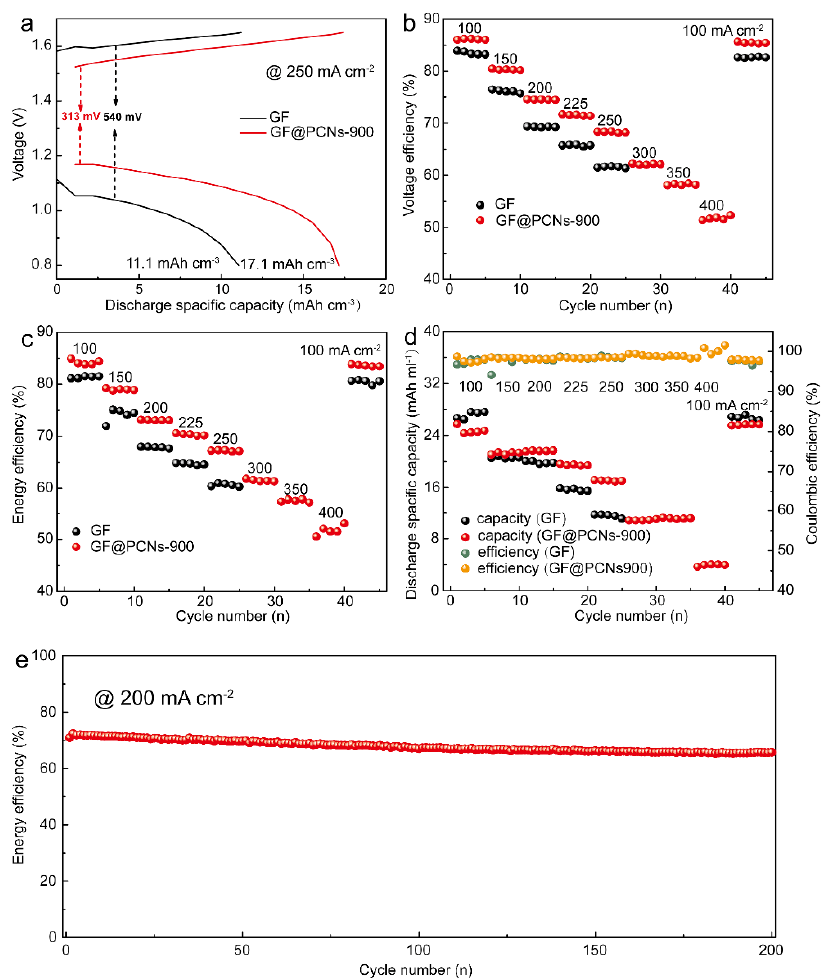
Figure 9. ( a ) Charge-discharge curve of the GF and GF@PCNs, ( b ) voltage efficiency, ( c ) energy efficiency, ( d ) discharge specific capacity and ( e ) cycling performances of GF@PCNs electrodes at 200 mA cm − 2 .